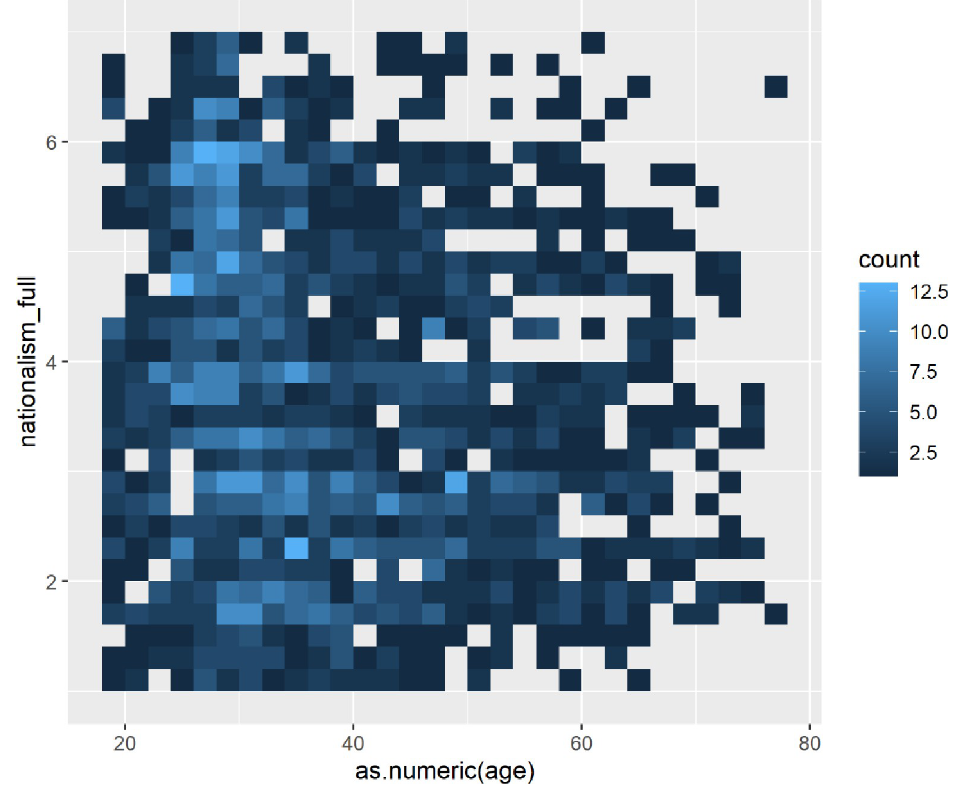
Fig 8. Heat map showing clusters of nationalism by